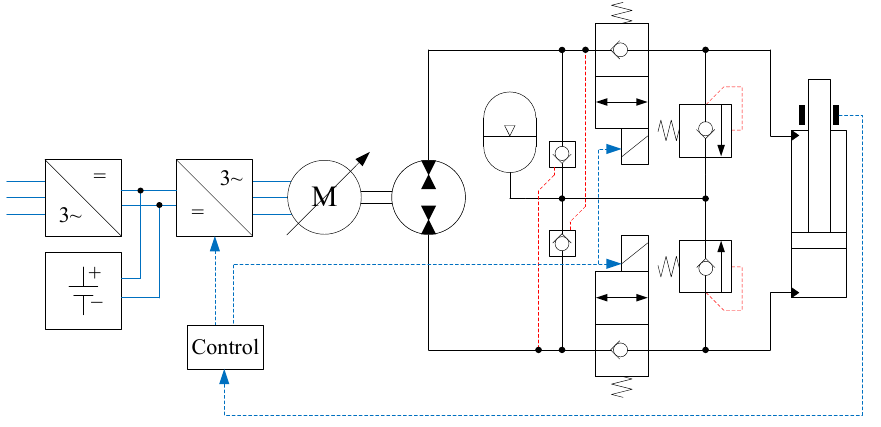
Figure 1. Proposed concept for the EHA.